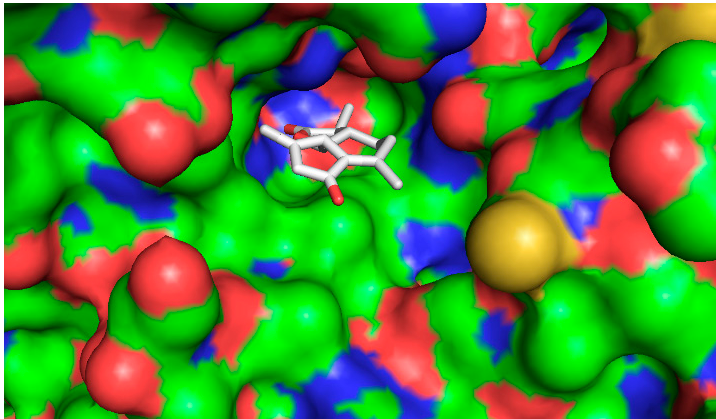
Figure 11. Bound conformer of ligands interacting with the substrate binding sites of HMGR for Leucodin (CP2).